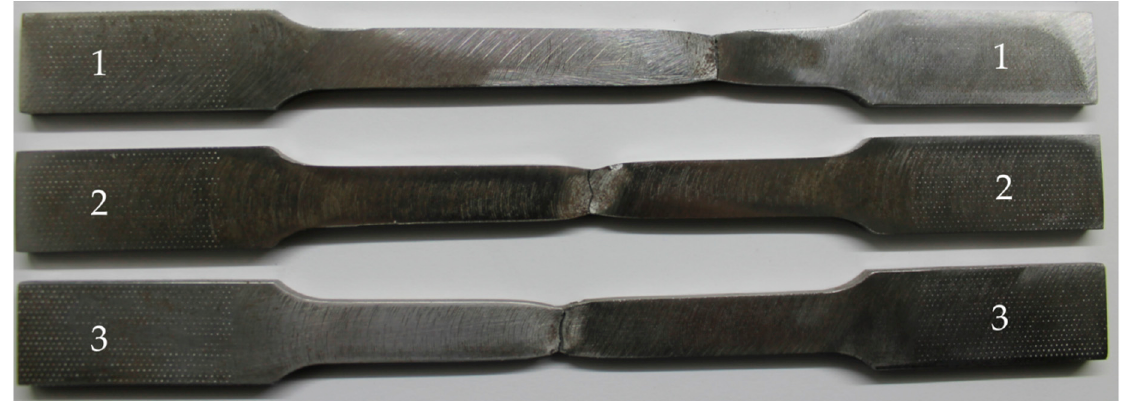
Figure 9. S355J2+N steel specimens after the experimental uniaxial tests.